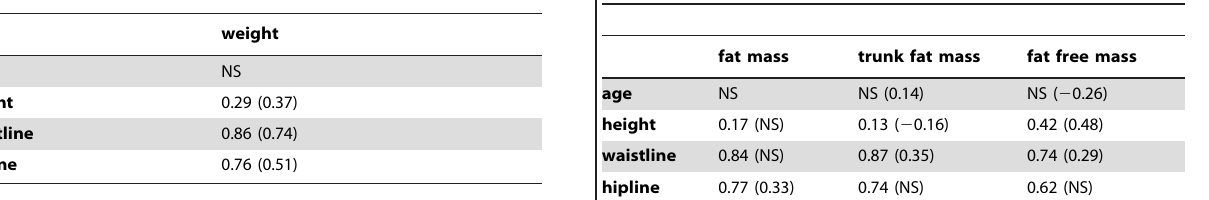
Table 3. Pearson partial correlation coefficients between anthropometric variables and DXA-derived body compartments for the full DXA data set (n=